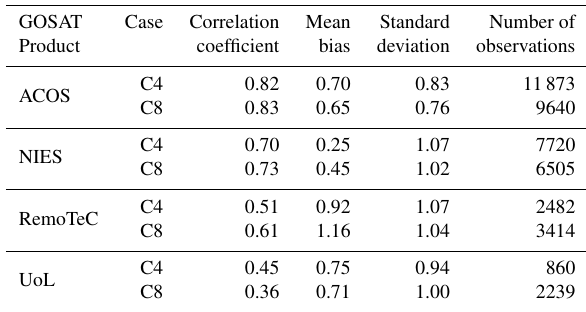
Table 10. Comparison of collocation methods C4 and C8 using ACOS, NIES, RemoTeC and UoL GOSAT products near the Re- union Island site. The PPDF GOSAT product does not include any observations near the Reunion Island